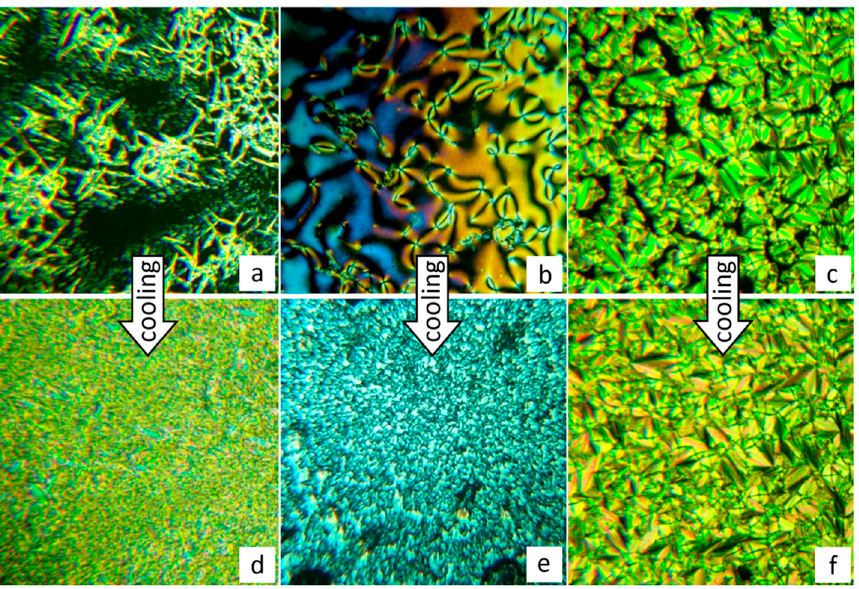
Figure 11. 500 × 500 µm POM textures of poly(BVK) at 66 ( a ) and 25 °C ( d ), poly(TVK) at 271 ( b ) and 25 °C ( e ), poly(QVK) at 245 ( c ), and 25 °C ( f ).